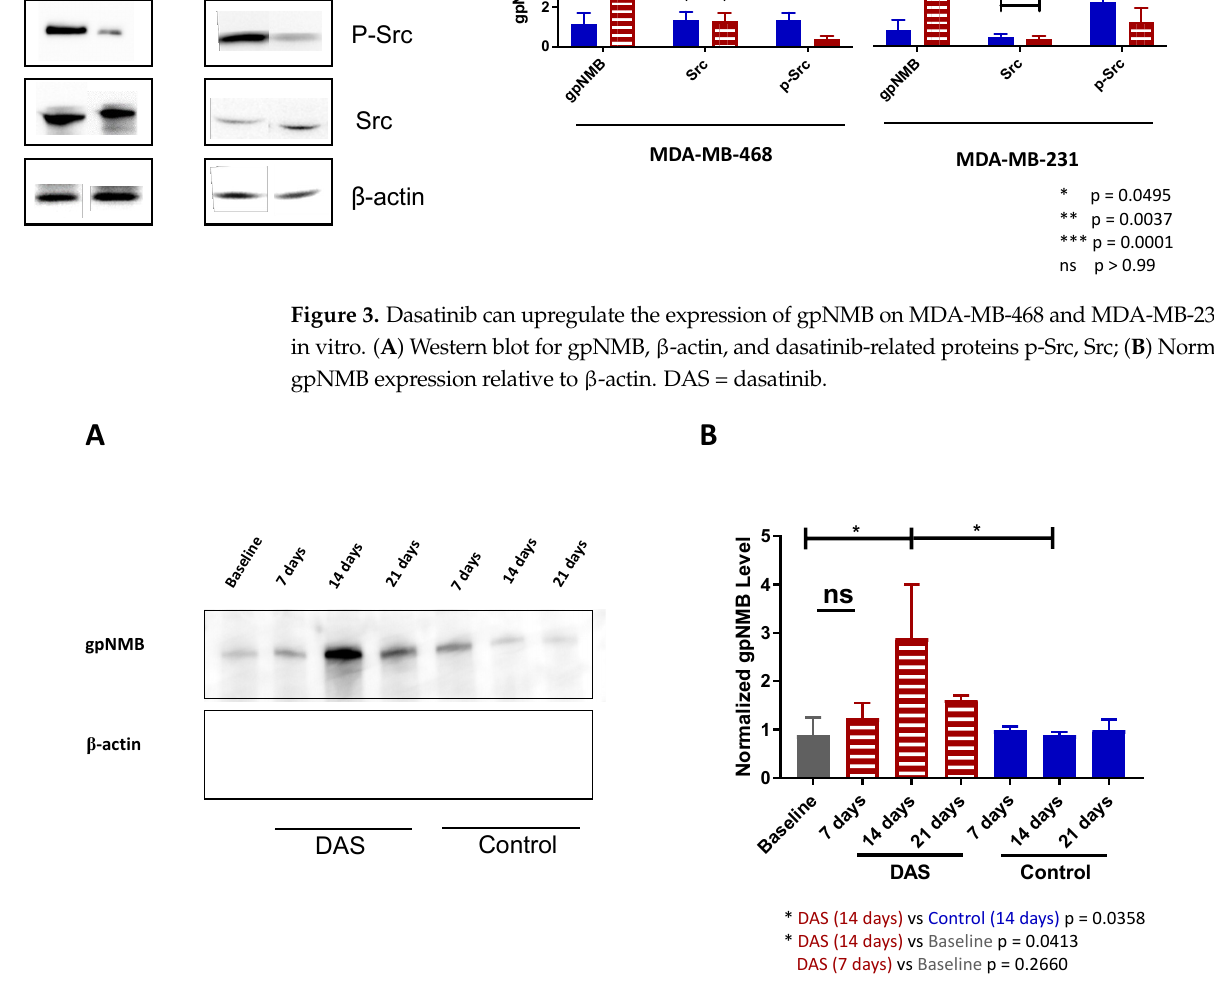
Figure 3. Dasatinib can upregulate the expression of gpNMB on MDA-MB-468 and MDA-MB-231 cells in vitro. ( A ) Western blot for gpNMB, ꞵ -actin, and dasatinib-related proteins p-Src, Src; ( B ) Normalized gpNMB expression relative to ꞵ -actin. DAS = dasatinib.